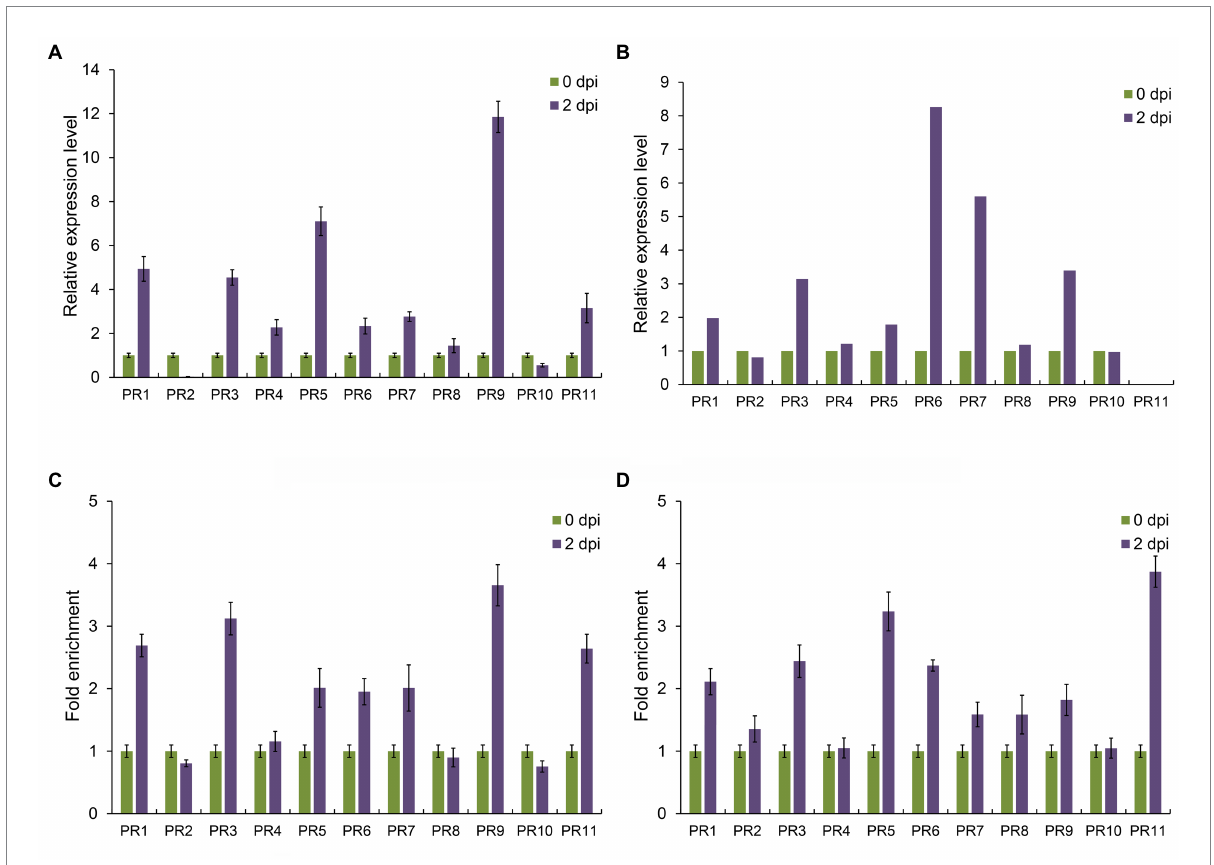
FIGURE 7 2-Hydroxyisobutyrylation affects gene expression of pathogenesis-related protein in maize. (A) Relative expression levels of PR genes under Fusarium graminearum infection. Data are the mean ± SEM of three independent experiments. (B) Relative expression levels of PR proteins under F. graminearum infection based on proteomics data. (C) Fold enrichment of histone Khib levels at the PR gene bodies after F. graminearum infection in maize. Data are the mean ± SEM of three independent experiments. (D) Fold enrichment of histone H4 acetylation levels at the PR gene bodies after F. graminearum infection in maize. Data are the mean ± SEM of three independent